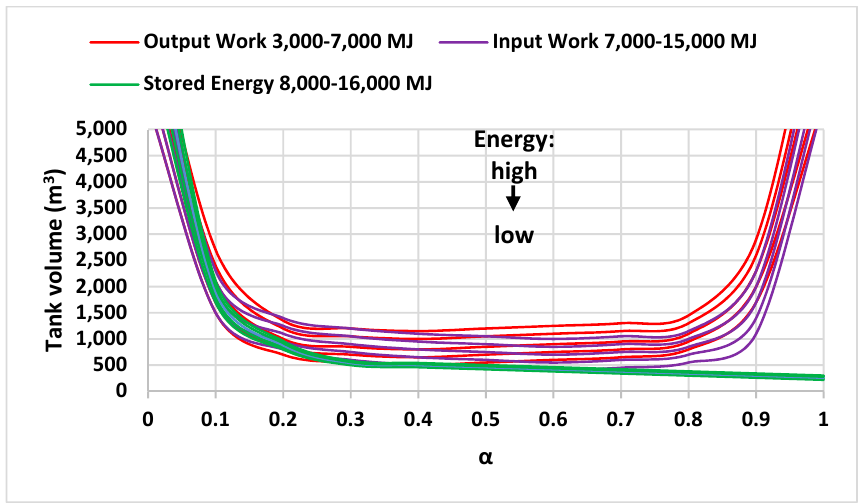
Figure 18. Reservoir volume changes about α for different values of input work, output work, and stored energy for a specific pressure (20 MPa).